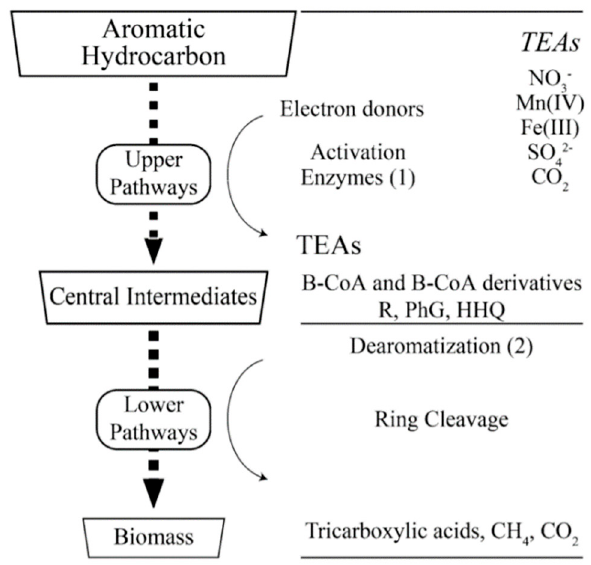
Figure 1. Bacterial pathways for aromatic hydrocarbon anaerobic degradation [47].